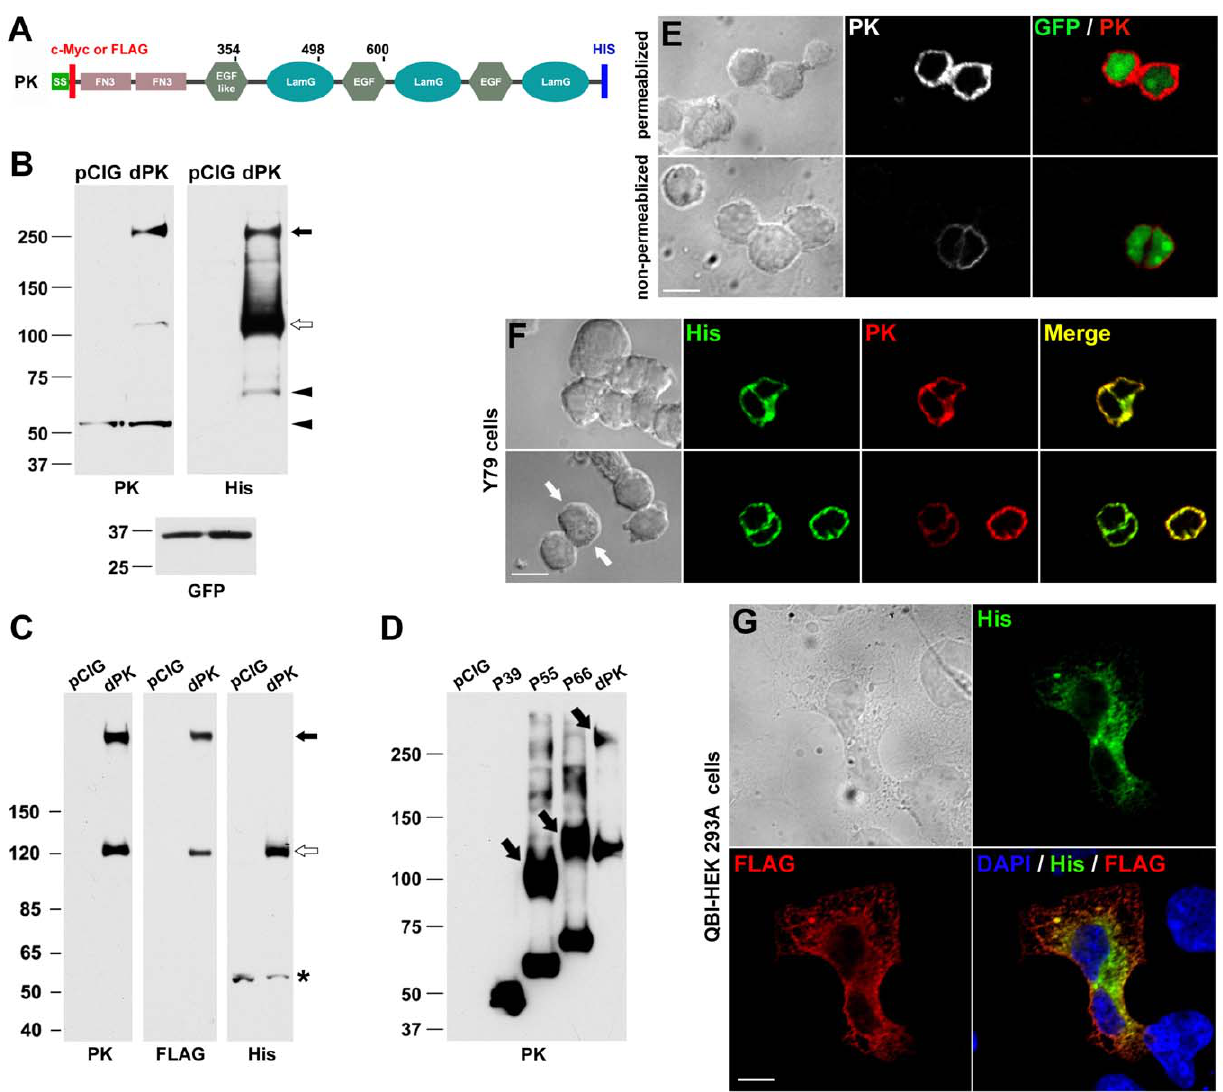
Figure 3. C-terminal fragment detected in Y79 cells expressing exogenous pikachurin. (A) Schematic of c-Myc/His tagged murine pikachurin (PK). SS, signal sequence; FN3, fibronectin type 3 domain; LamG, laminin G domain. The numbers indicate the end positions of three N- terminal mutants. (B) Western blots of Y79 cell lysates after transfection of double-tagged pikachurin (dPK). pCIG, pCIG-transfected controls. Note the presence of pikachurin monomer (open arrow), dimer (filled arrow), and fragments (arrowheads). PK antibody- and His antibody-labeled fragments are from the N and C-terminal respectively; PK antibody labels both endogenous and exogenous protein. (C) Western blots of QBI-HEK 293A cell lysates after transfection of dPK. There are no fragments of pikachurin but monomers (open arrow) and dimers (filled arrow) are present. A small band (*), found in both control and dPK-transfected samples, is believed to be non-specific. (D) N-terminal mutants (P39, P55 and P66) were used to transfect QBI-HEK 293A cells and their expression was confirmed on Western blot. Similar to dPK, P55 and P66 not only existed in monomers but also formed dimers (arrows). However, P39 did not dimerize indicating the loss of the site of dimerization. (E) Pikachurin (PK) immunofluorescence of dPK- transfected Y79 cells. Nuclear GFP marks transfected cells. Labeling is primarily due to overexpressed exogenous PK. Non-permeabilized immunolabeling highlights cell surface label. Bar=10 m m. (F) Co-immunolabeling of PK and His tag in dPK-transfected Y79 cells. Immunofluorescence of PK and His tag is generally overlapping. However, some cells have relatively stronger His signals than their pikachurin counterparts (arrows). Bar=10 m m. (G) Co-immunolabeling of FLAG and His tags in dPK-transfected QBI-HEK 293A cells. Large cell size allows the separation of signals into cytoplasmic and perinuclear regions respectively. Bar=20 m